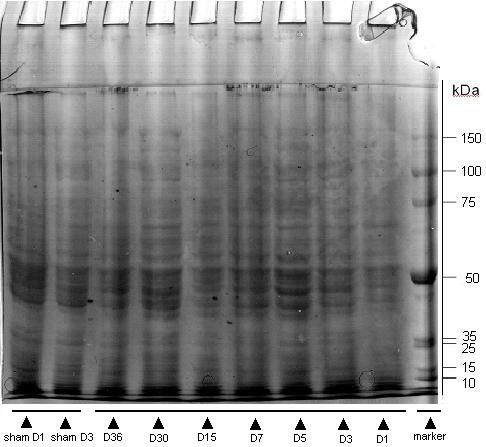
Representative image of an SDS-PAGE gel separating mouse liver protein samples. 60 μg of each sample from either sham-operated or 50% PH group recovered for different time period was separated on 10% SDS polyacrylamide gels. The gel was stained with Colloidal Coomassie Brilliant Blue G for 4 hours, and destained in a destaining solution.